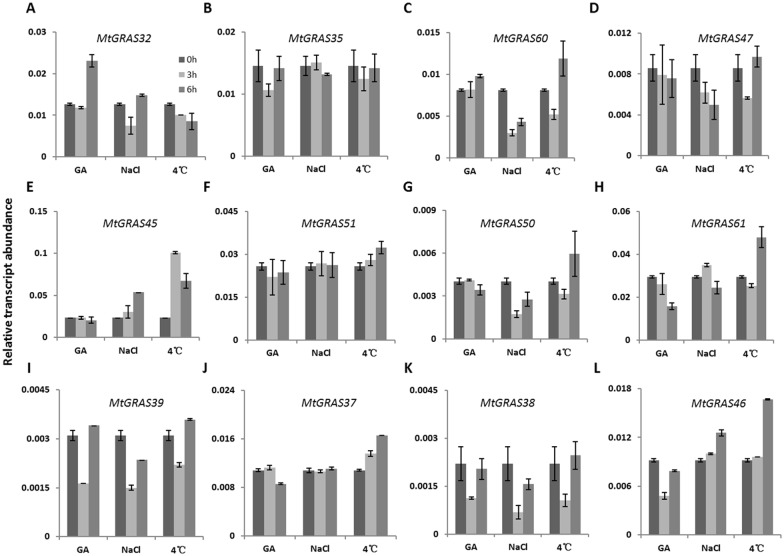
Relative expression levels of MtGRAS genes in different abiotic stress treatments.Three-week-old M. truncatula (cv. Jemolong A17) seedlings were subjected to various stress treatments including GA3 gibberellin (30 μM), cold (4°C), and salt (200 mM). The expression level was measured at 0h, 3hm and 6h after treatment. Error bars show the standard error of three replicates.